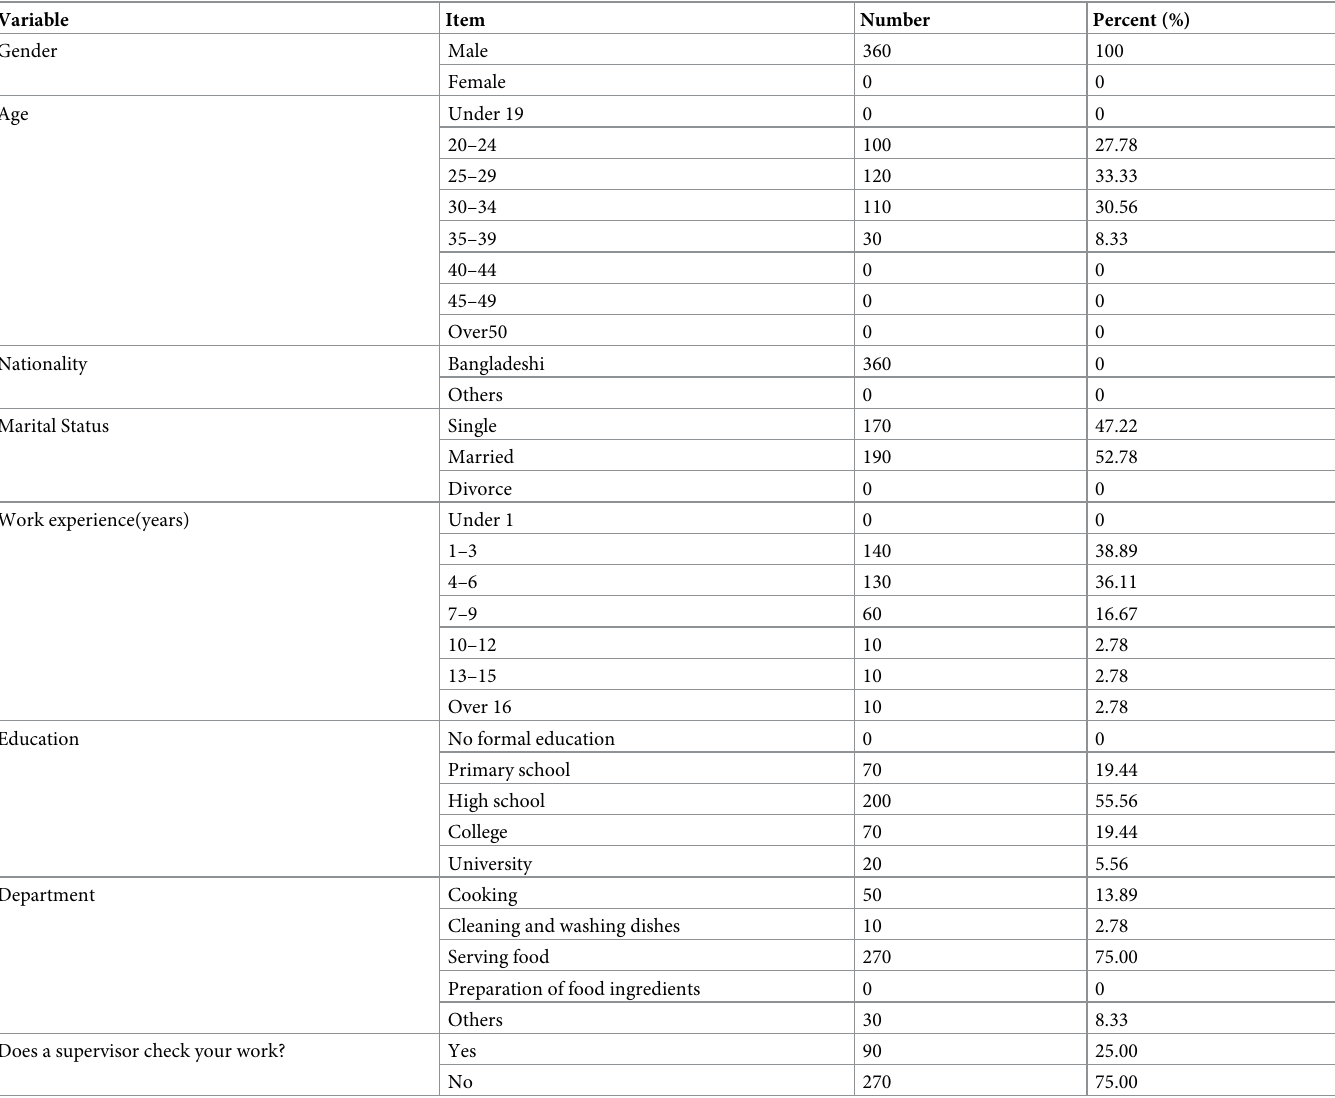
Table 1. Participant’s demographic